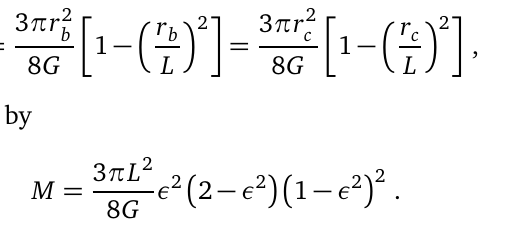
in orange, the c